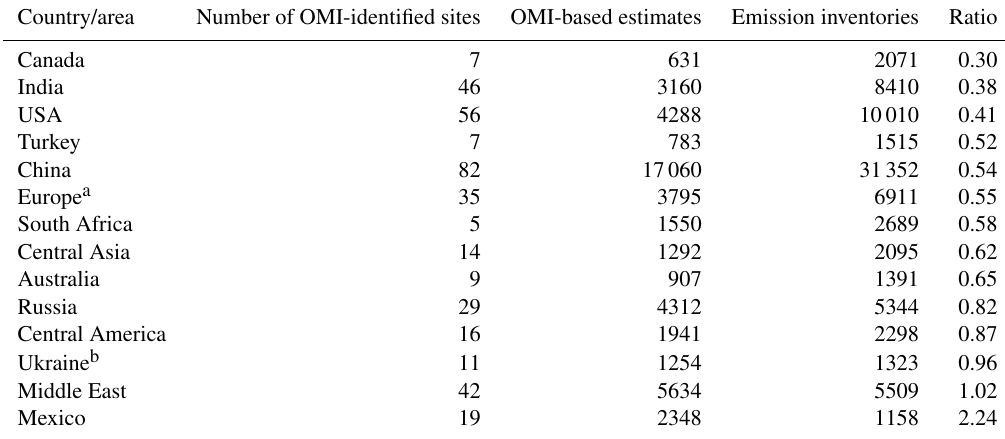
Table 2. Average total SO 2 emissions for 2005–2011 by region (ktyr − 1 ) estimated from OMI data and from emission inventories (Klimont et al., 2013), and the ratio of the OMI-based estimates to the inventory values. Country/area Number of OMI-identified sites OMI-based estimates Emission inventories